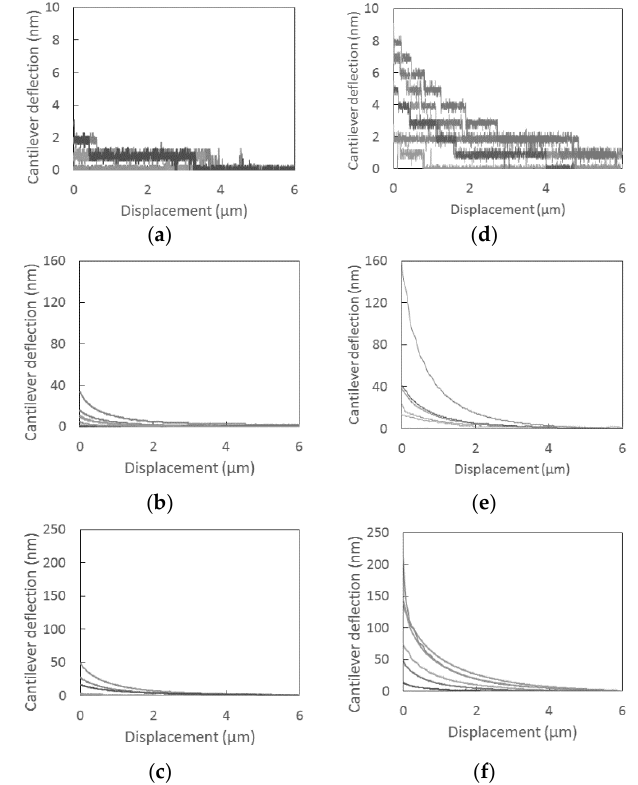
Figure 8. Deflection-displacement curves for ( a – c ) non-processed and ( d – f ) FIB-processed cantilevers, and charge-to-mass-ratios of ( a , d ) 0 μC/g (not mixed with carrier); ( b , e ) q/m = −13.6 μC/g; ( c , f ) q/m = −20.7 μC/g. The charge-to-mass ratios q/m were obtained using the blow-off method. Note that the toner particles were charged by mixing with the carrier, not contact-electrified. Also note that the Y-axis range is different among each charge-to-mass ratio to more easily compare the effect of FIB-milling.